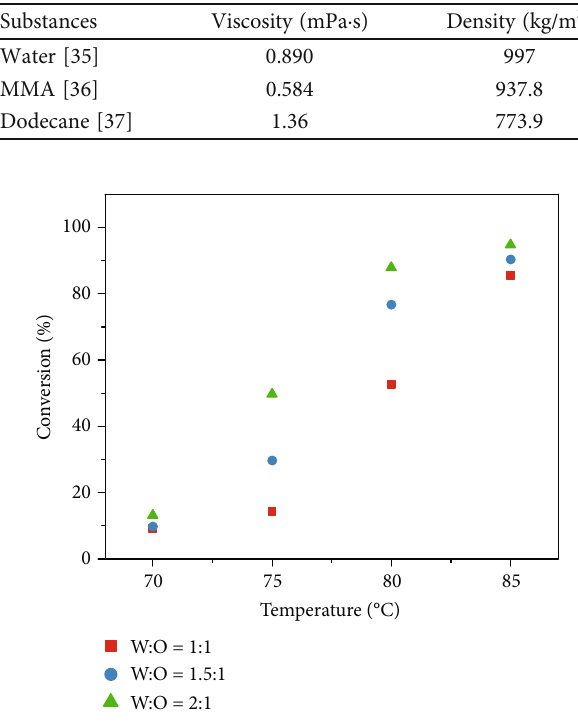
Figure 6: E ff ect of the volumetric fl ow ratio on the monomer conversion at di ff erent temperatures ( t 1 = t 2 = 20 min, and the concentration of APS was 5 mM).